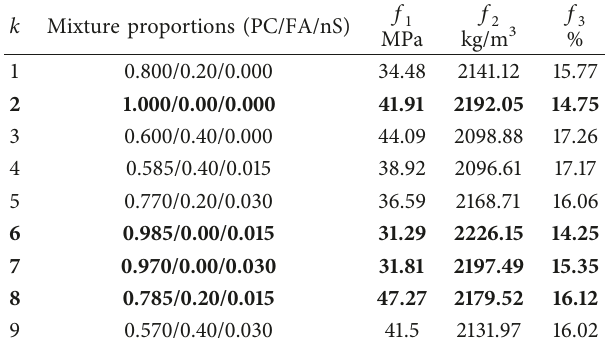
Table 11: Optimization results at day 28 where the mixtures in bold belong to the Pareto-efficient frontier.